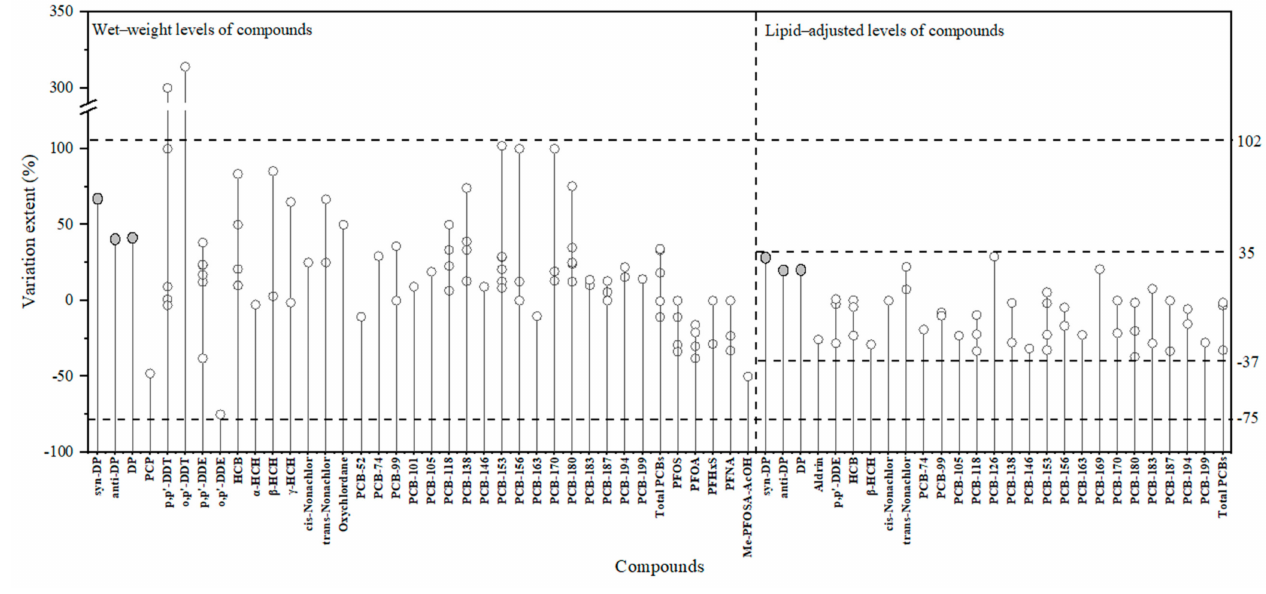
Figure 2. Variation extent (%) of DP in this study and other POPs in published literature. (The grey “ ” represents the variation extent of DP in this study, and the blank “ (cid:35) extent of POPs in published literature, detailed information is available in Table S3. The left part of the dotted line represents the levels of DP and POPs based on wet weight, and the right part of the dotted line represents the levels of DP and POPs based on lipid-adjusted weight. The horizontal dotted lines represent the range of POP variation extents based on wet-weight and lipid-adjusted